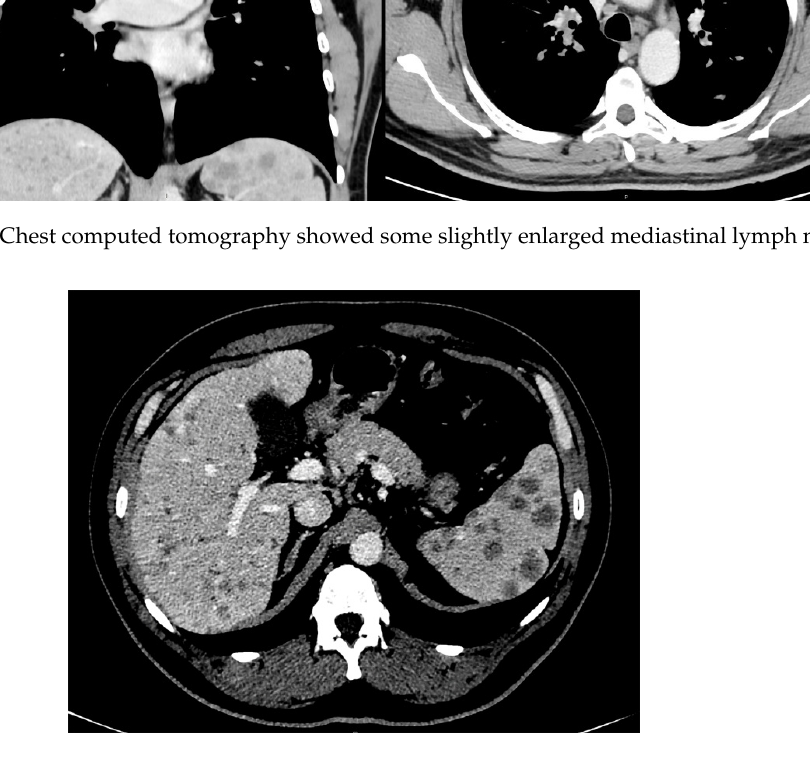
Figure 3. Abdominal contrast-enhanced computed tomography, in portal phase, showed multiple nodules ranging from 1.0 or 2.0 mm to 0.75 cm in diameter diffusely distributed in the liver, and ranging from 1.0 mm to 2.0 cm in the